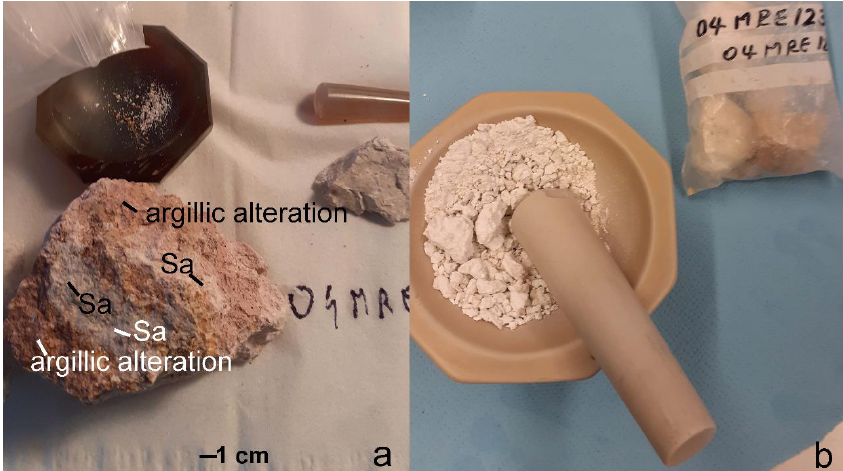
Figure 2. ( a ) Rock specimen 04MRE123, selected for clay extraction, where the occurrence of sanidine and argillic alteration is shown. ( b ) Hammered rock pieces in the agate mortar before X-ray diffraction, whole-rock measurement and clay extraction procedure.